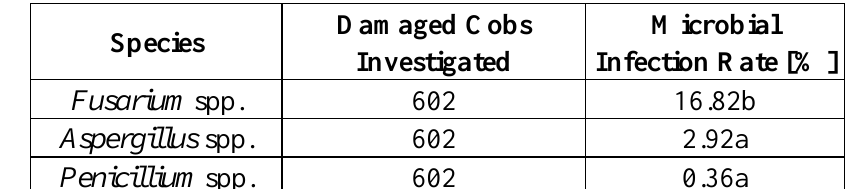
Table 5. Fungal infection related to larval damage ( Helicoverpa armigera and Ostrinia nubilalis ) of cobs (DK-440).